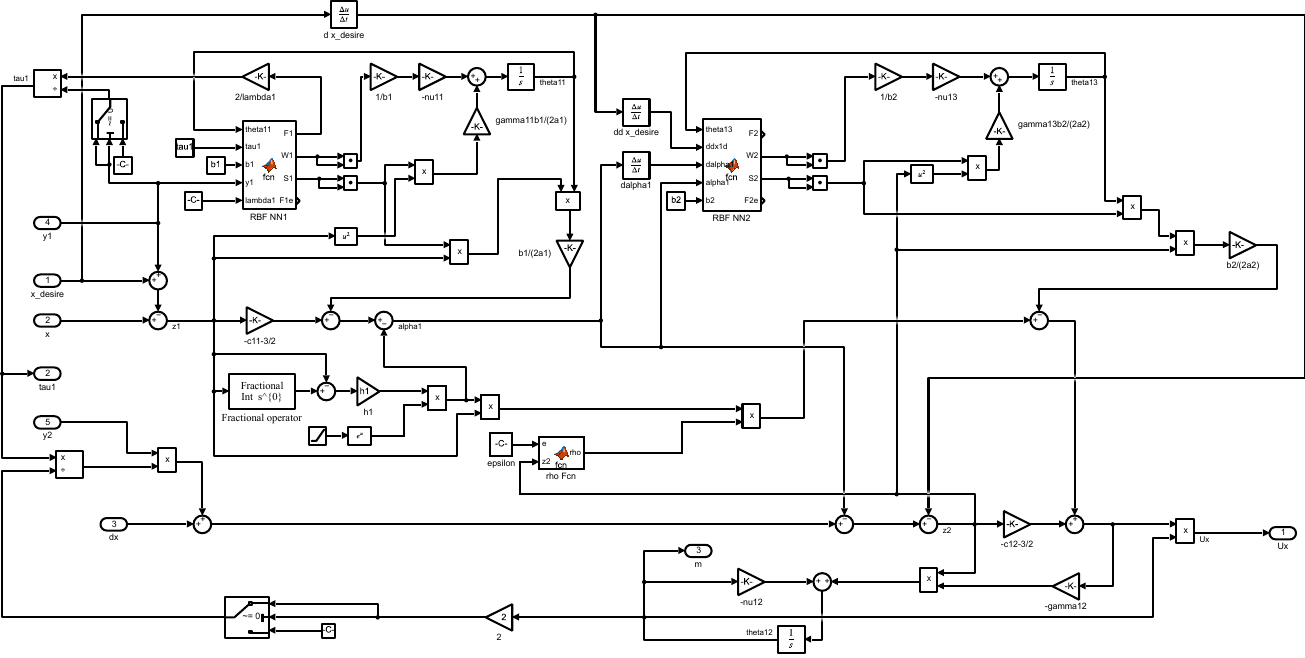
Figure A3. Simulink diagram of the X subsystem control block in the position controller.